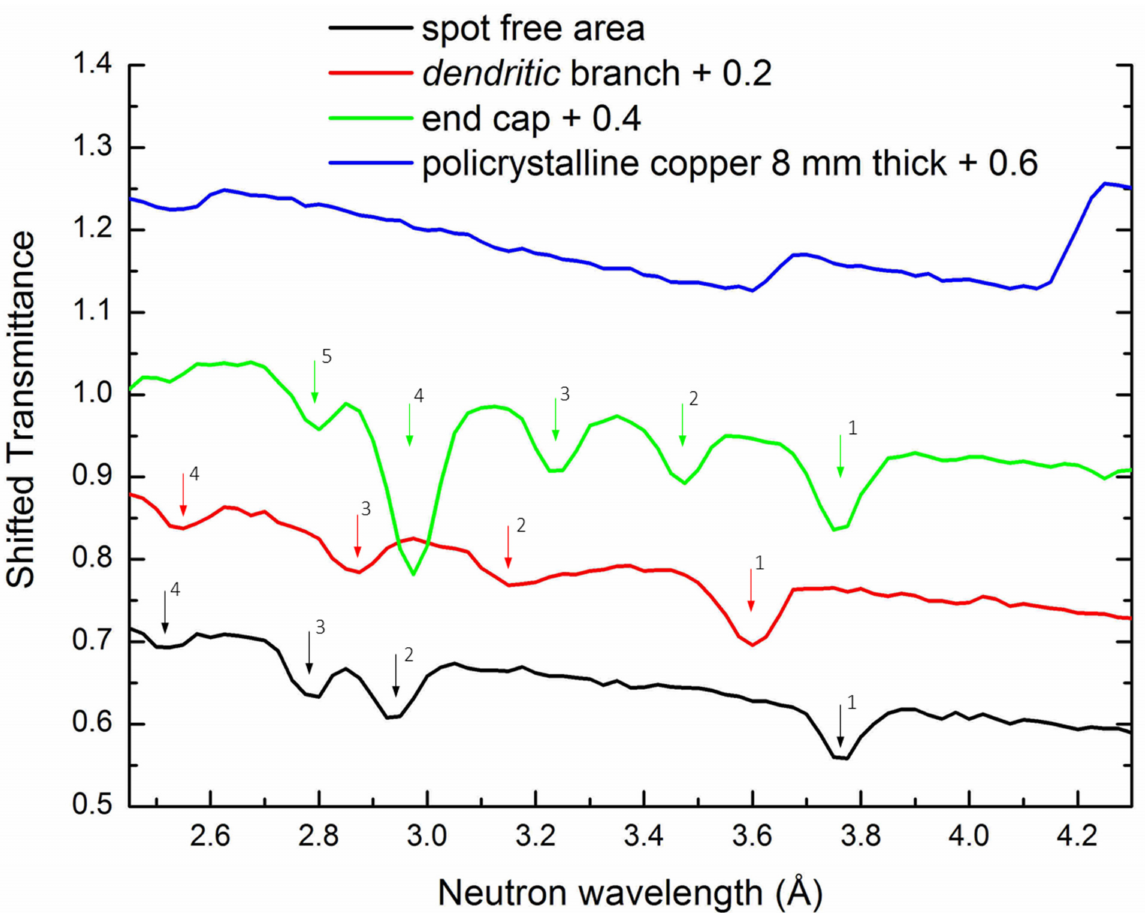
Figure 2. Transmission spectra as a function of neutron wavelength in selected sample areas showing that no evidence of Bragg edge structure is visible at all while a set of three or more broad dips are visible. The slight tilt of the reference value is related to the linear increase of the absorption cross section of copper with neutron wavelength. The experimental profile of Bragg edge originated by polycrystalline isotropic pure copper solid sample is shown in blue lines. The 111, 200, 220 Bragg edges are evident, ideally positioned respectively at 4.174, 3.6147 and 2.556